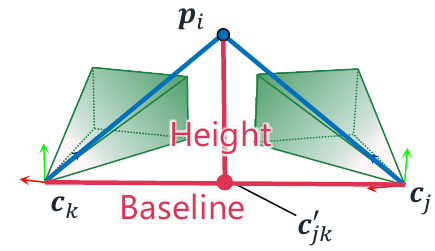
𝑗𝑗𝑘𝑘′ Figure 4. Baseline and height ratio. 𝒄𝒄